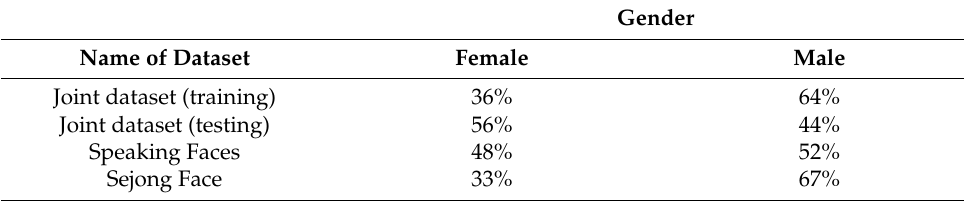
Table 1. Gender split of